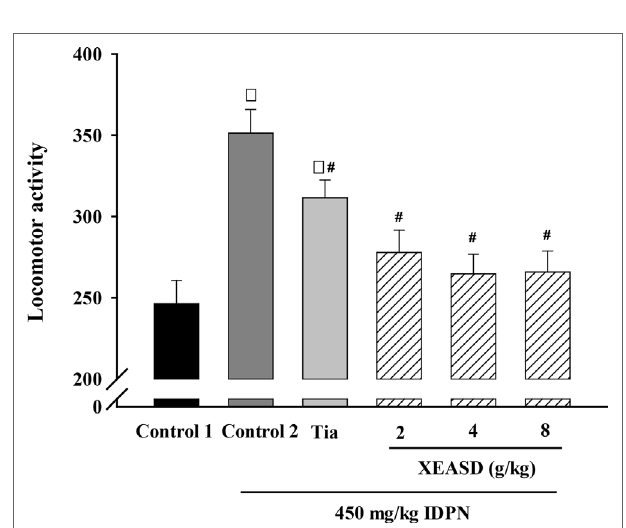
FIGURE 2 | Effects of XEASD treatment on locomotor activity of IDPN- induced TS mice. Locomotor activity was measured as described in Materials and Methods. Control 1 represents normal control mice; control 2 represents IDPN-challenged control mice. Each bar represents mean ± SEM, with n ≥ 23. * P < 0.05, significantly different from the control 1; # P < 0.05, significantly different from IDPN control 2. Locomotor activity of control 1 (mean ± S.E.M). = 247 ±